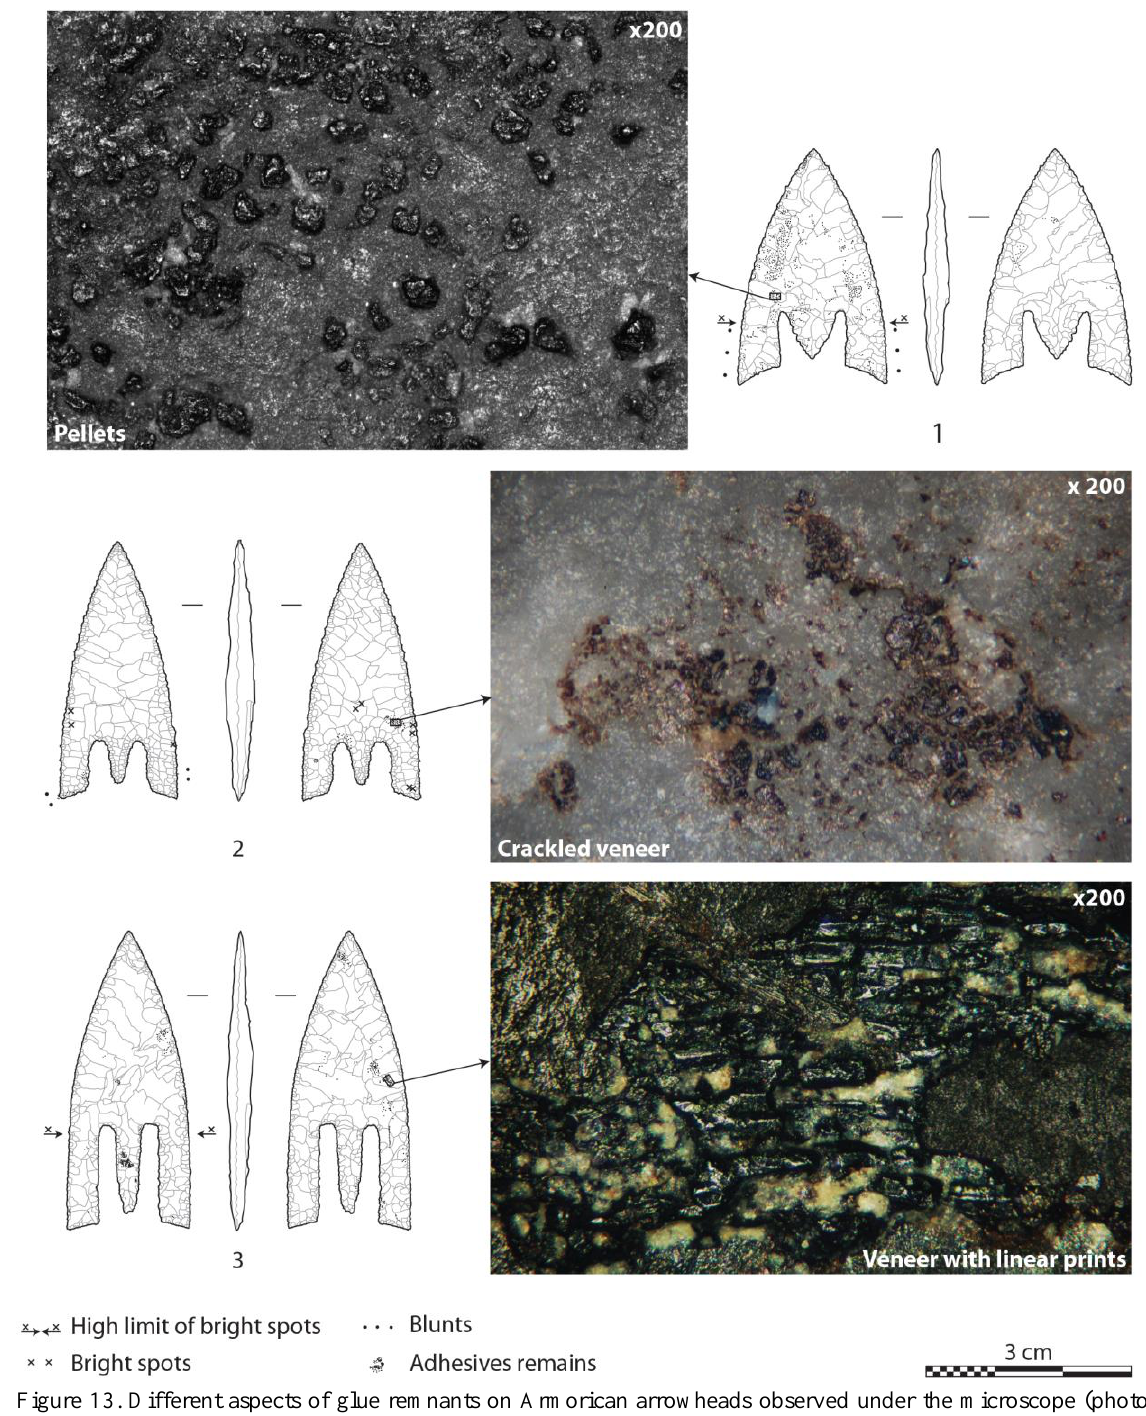
Figure 13. Different aspects of glue remnants on Armorican arrowheads observed under the microscope (photo C. Guéret, C. Nicolas; drawings C. Nicolas). 1. arrowhead from Brun-Bras barrow, Saint-Adrien, Côtes- d'Armor; 2. arrowhead from Crec’h-Perros-Guirec, Côtes-d’Armor; 3. arrowhead from Prat-ar-Simon-Pella grave, Lannilis,